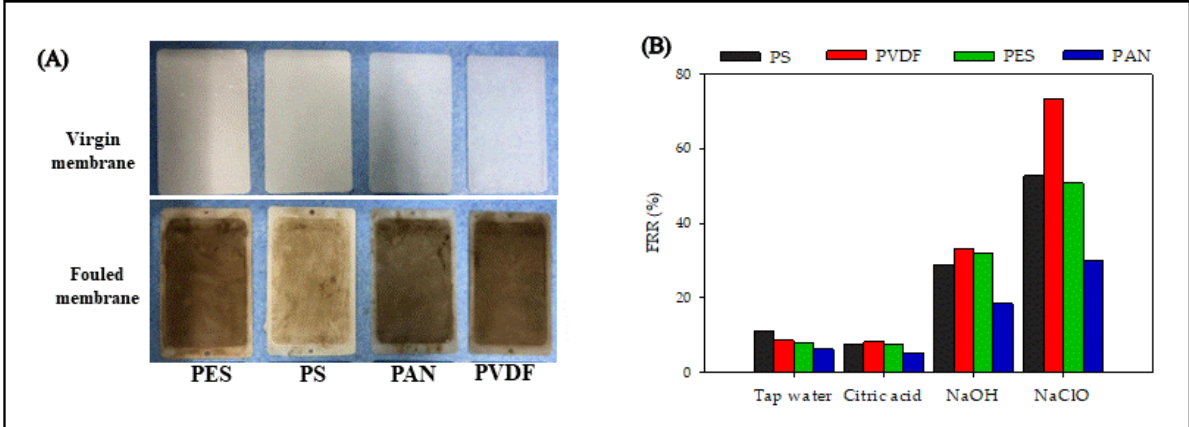
Figure 7. Cleaning effect of UF membranes with different materials: ( A ) digital pictures for the virgin and fouled membranes, ( B ) the membrane flux recovery rate of different chemical agents.